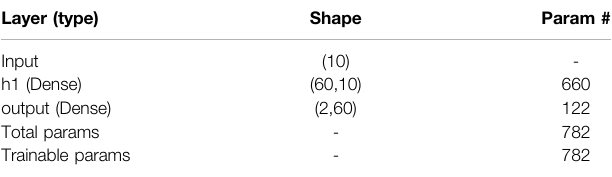
TABLE 1 | Proposed model layer con fi guration. Layer (type) Shape